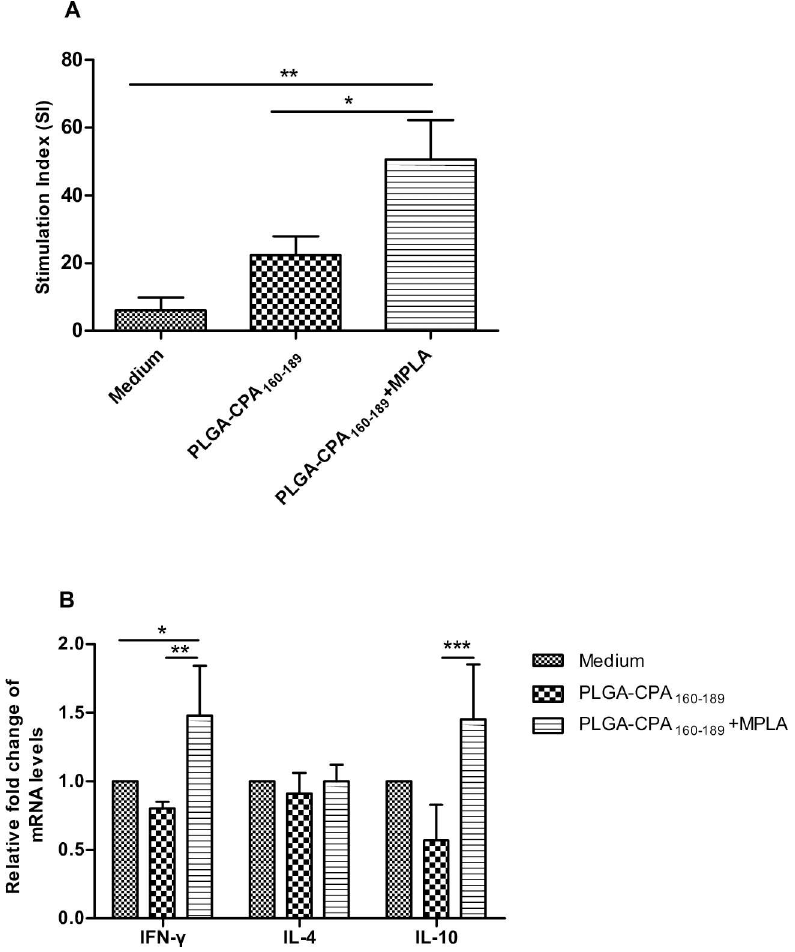
Fig 4. Antigen-presentation efficacyof PLGA NPs-pulsed DCs. (A) Antigen-presentation efficacy of PLGA NPs-pulsedDCs to naive splenocytes. Splenocytes treated with medium alone served as negative control. The results are the mean stimulationindex (S.I.) ± SD from three independent experiments. (B) IFN- γ , IL-4 and IL-10 mRNA expressionin DCs-primed splenocytesby qRT-PCR. Results are presented as means ± SD of three independent experiments. * p < 0.05, ** p < 0.01, *** p < 0.001were assessedby one-wayANOVA and Tukey’s multiple